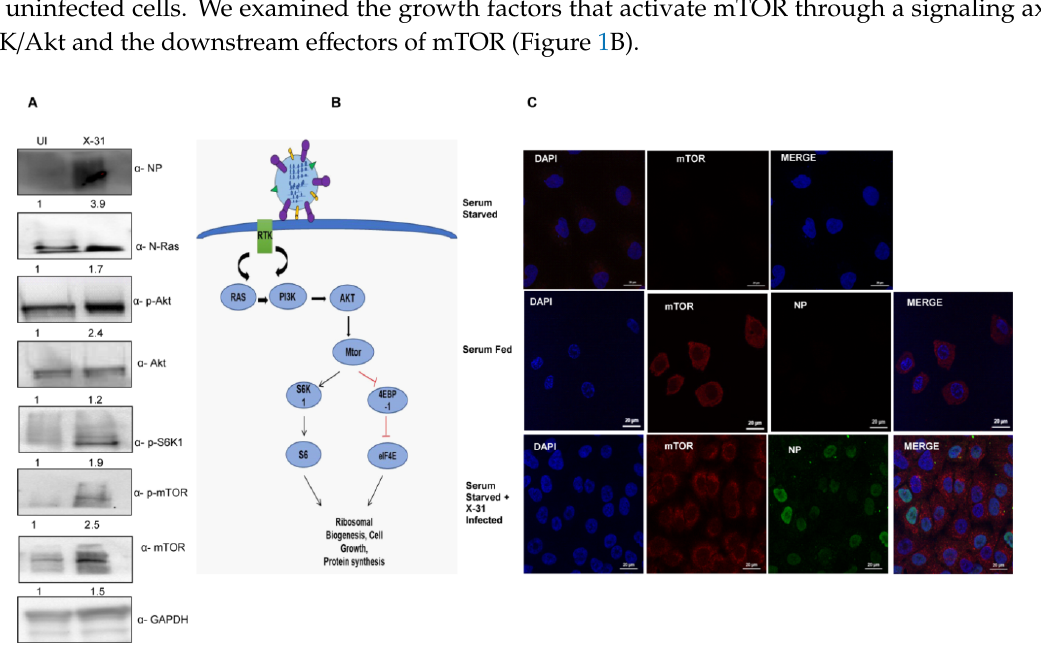
Figure 1. Induction of Akt / mTOR pathway by IAV. ( A ) X-31 infected A549 cells were infected at an MOI of 1 for 24 h or mock-infected (UI) in serum-starved cells and the whole-cell lysates from the same samples were resolved on SDS-PAGE for detection of NP, N-Ras, p-Akt, Akt, p-S6K1, p-mTOR, mTOR and GAPDH. ( B ) Schematic illustration for Ras / Akt / mTOR pathway. ( C ) Serum starved A549 cells (panel I) were uninfected, serum-fed cells were mock-infected (panel II) and serum-starved A549 cells infected with X-31 at MOI of 2 were fixed at 24 hpi and stained with DAPI for nucleus (blue), with goat anti-mouse antibody conjugated to Alexa 488 for NP (green), and with goat anti-rabbit antibody conjugated to Alexa-568 for mTOR (red). Scale is 20 µ